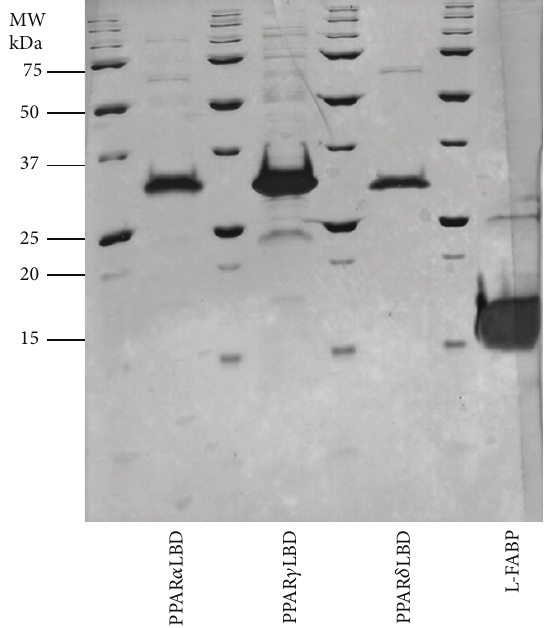
Figure 1: Purity of protein preparations used in this study. Protein samples were resolved by SDS-PAGE on 15% polyacrylamide gels and stained with silver. Gel lanes were loaded with ≥ 5 𝜇 g of protein, to allow for identification of residual contaminating protein species. Molecular weight standards are indicated on the